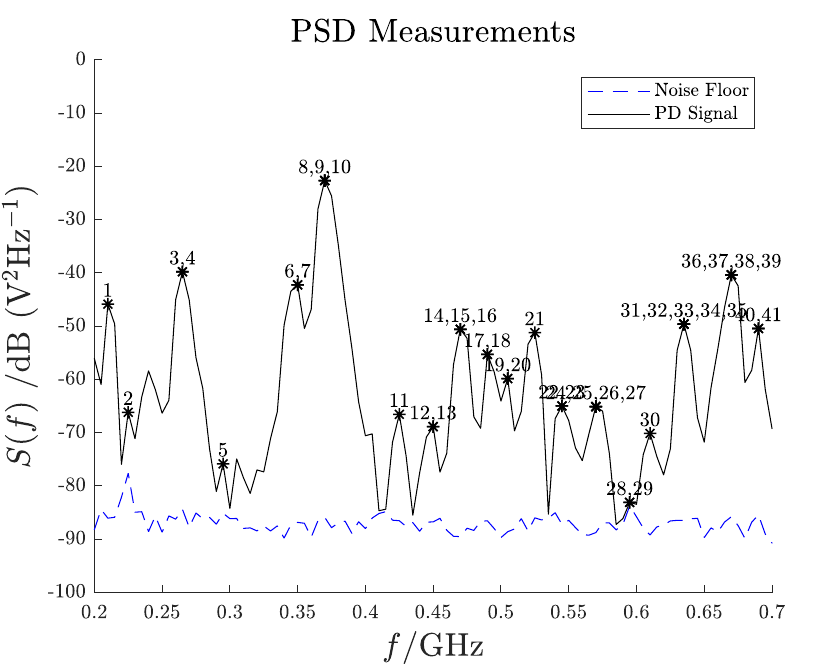
Figure 8. PD signal PSD. Each number corresponds to the closest numerical eigenfrequency. The dashed line shows the background noise of Figure 7.